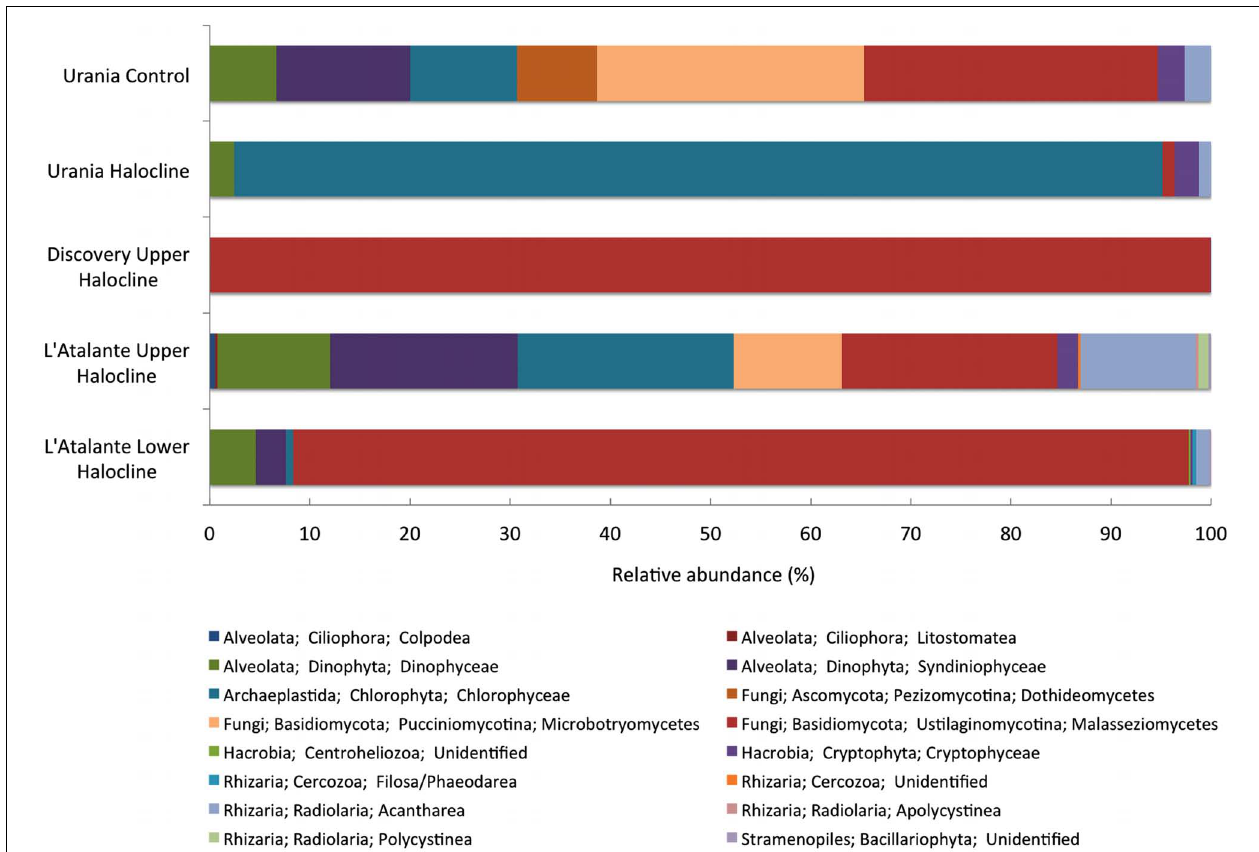
FIGURE 10 | Relative abundance (%) of rRNA signatures of unicellular eukaryotic groups of the DHAB sediments based onV4 SSU rRNA pyrotags clustered at 97% similarity. Taxonomic assignments were performed using BLAST implemented in QIIME against SILVA 111 database.